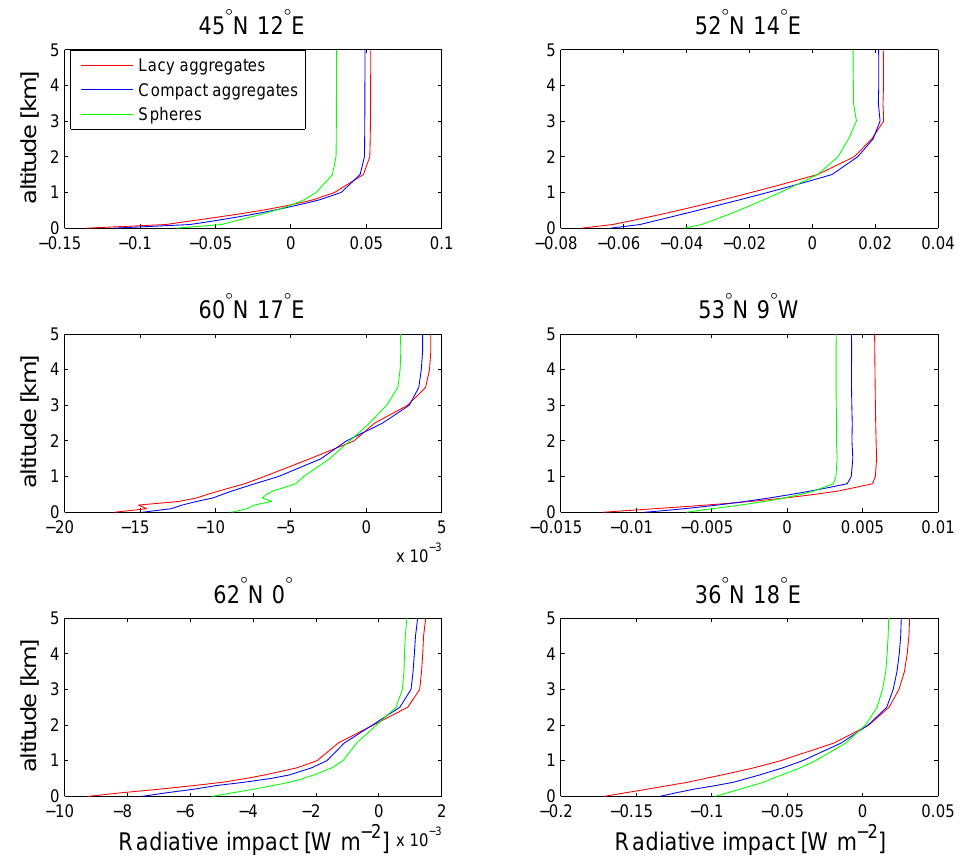
Fig. 7. As Fig. 4, but for the shortwave radiative impact (integrated over all SW